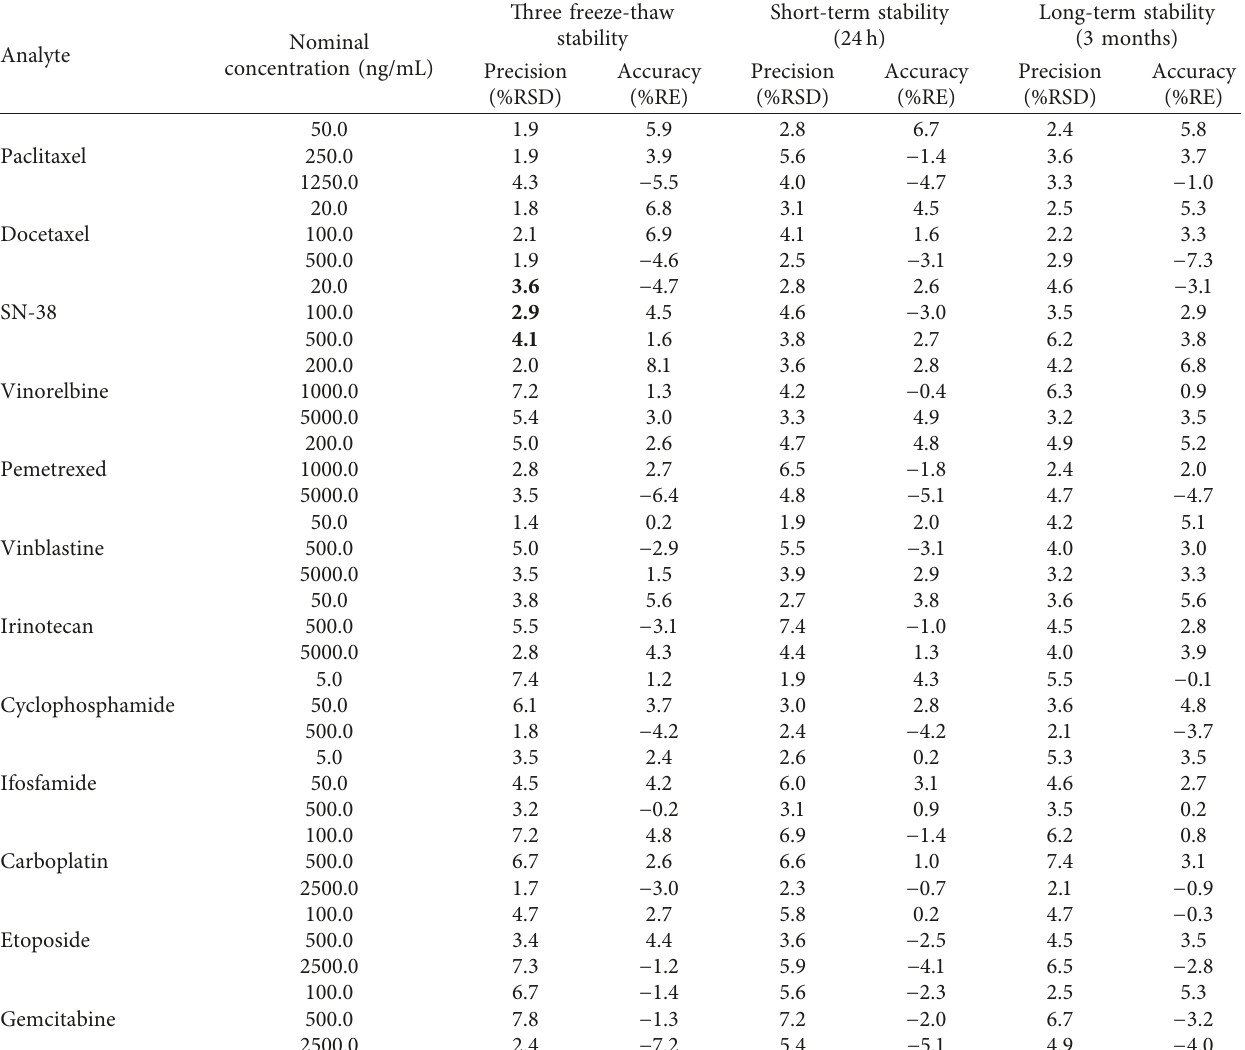
Table 6: Stability of analytes in human plasma ( n �